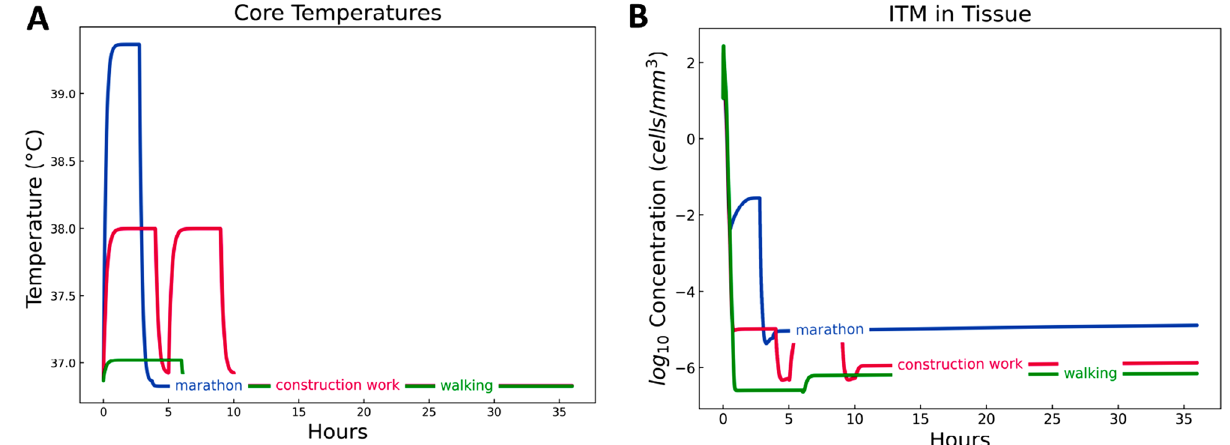
Figure 5. Dynamics of core temperatures and inflammation triggering moieties during and after three physical activities. The profiles of ITMs for marathon and walking follows that of the core temperatures. Two peaks in the ITM concentrations of construction work signify a 9-h work with an hour break in between. Marathon exhibits the highest induced ITMs, which remain at high level after 36 h, signifying the inability of the innate immune system to resolve the ongoing